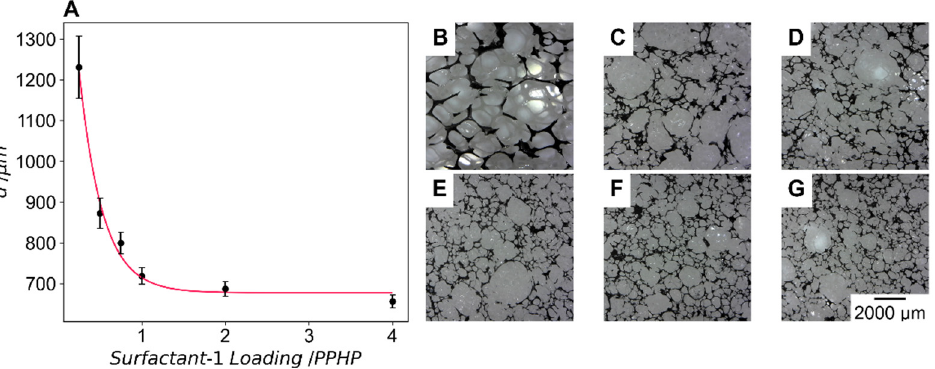
Figure 5. ( A ) The cell size of polyurethane as a function of surfactant-1 loading with the solid line indicating an exponential fit to the data, and the error bars indicating one standard error. ( B – G ) Optical microscope images of the foams with stained surfaces at surfactant-1 loadings of (B) 0.25 PPHP, ( C ) 0.5 PPHP, ( D ) 0.75 PPHP, ( E ) 1 PPHP, ( F ) 2 PPHP and ( G ) 4 PPHP .